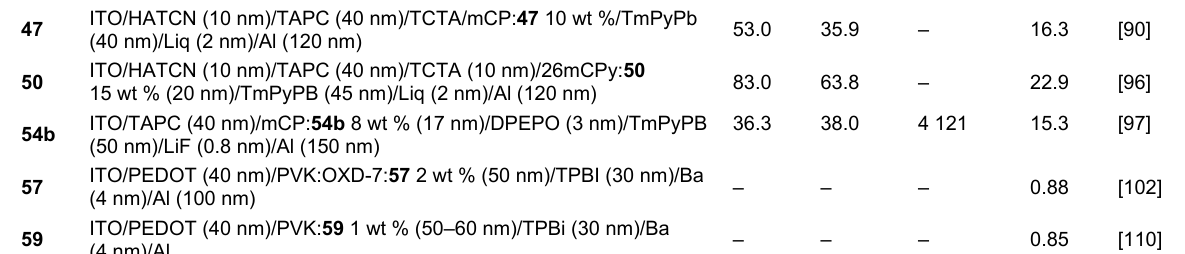
Table 1: EL device performances reported for selected examples of luminescent platinum(II) and platinum(IV) complexes reviewed in this manuscript. (continued)